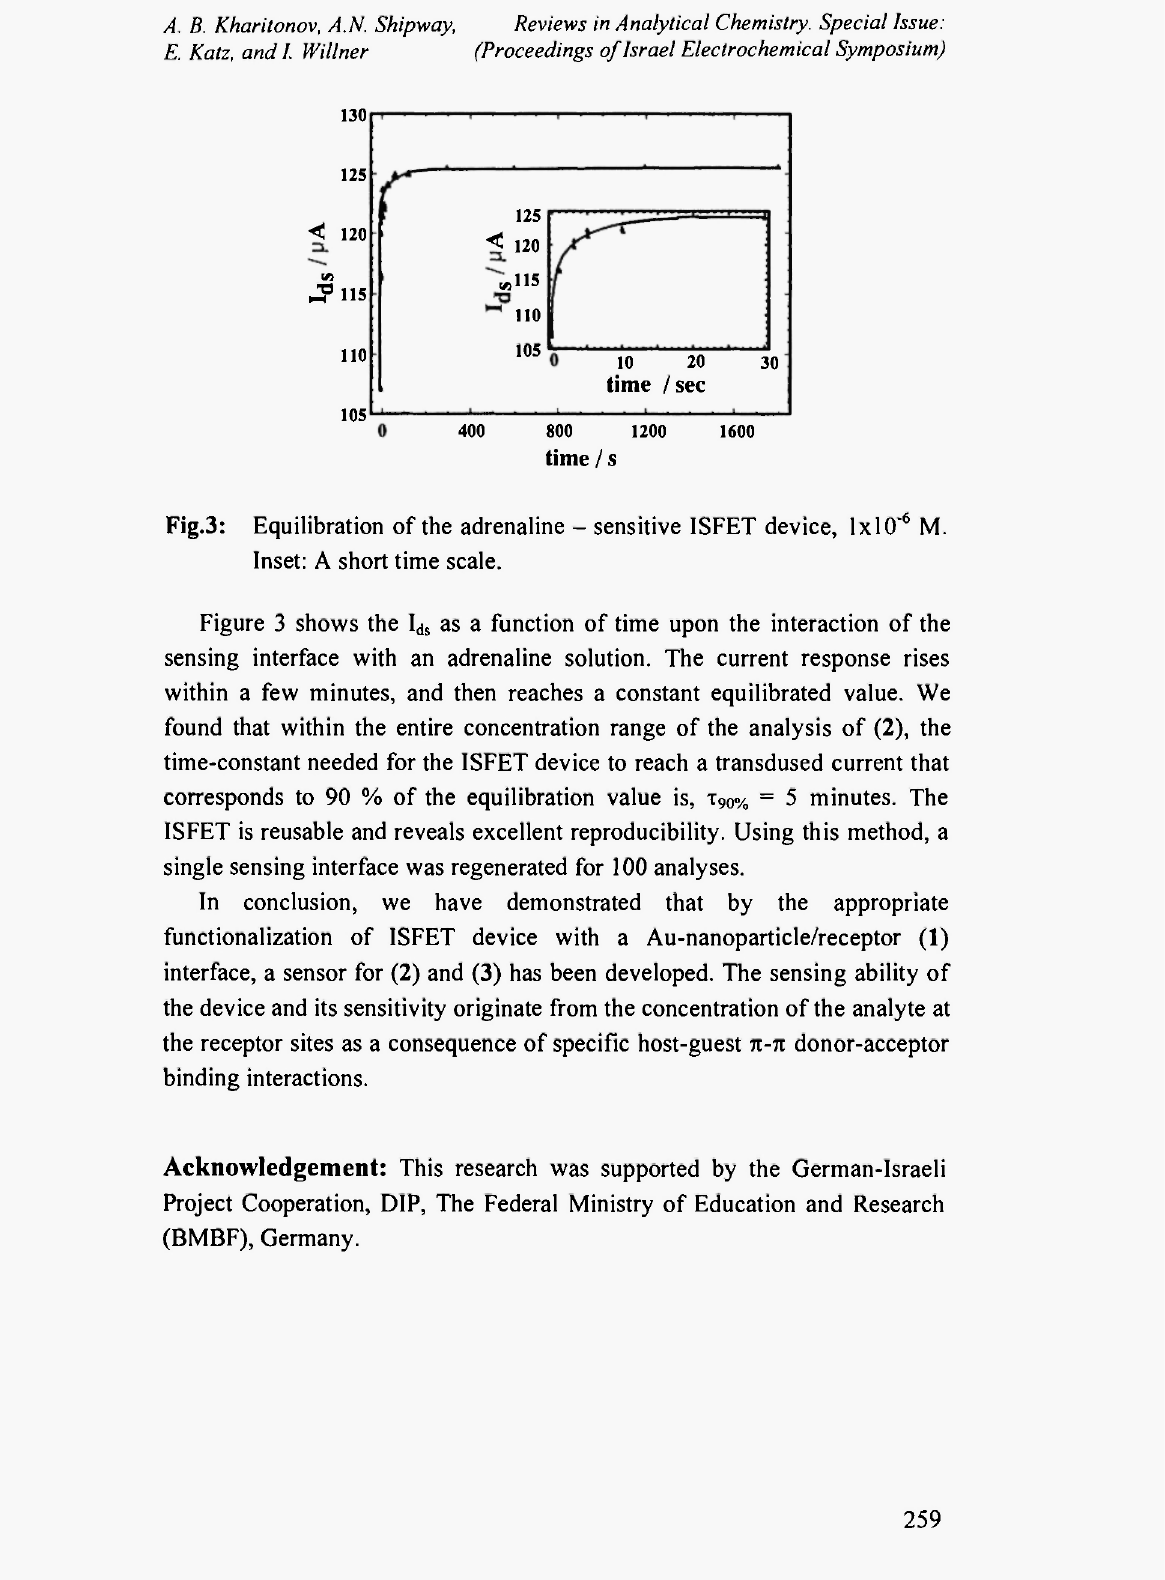
Fig.3: Equilibration of the adrenaline - sensitive ISFET device, lxlO" 6 M. Inset: A short time